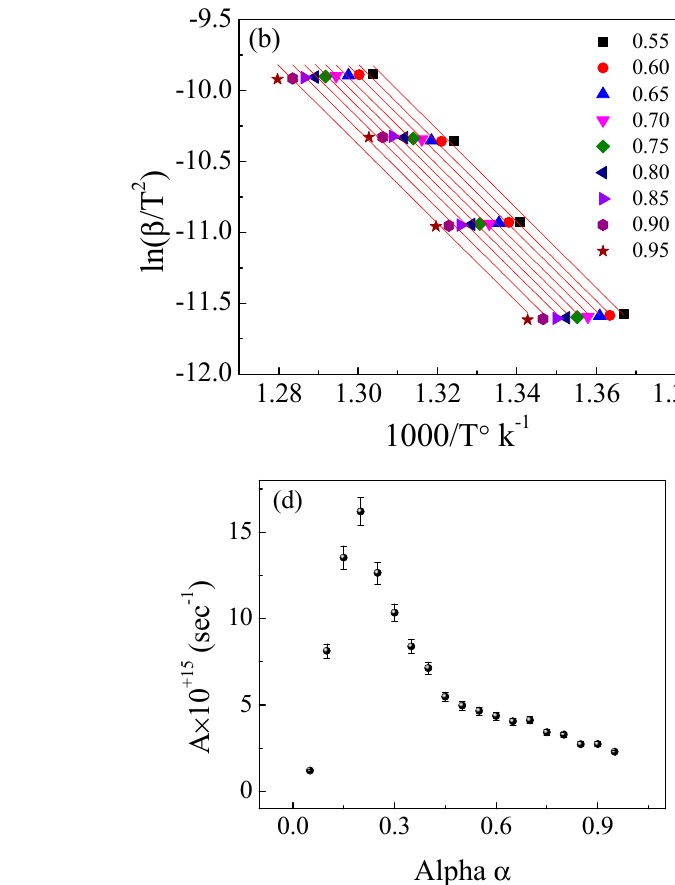
Figure 8. The Kissinger–Akahira–Sunose method for the EPDM host composite: ( a , b ) ln( β /T 2 ) versus temperature; ( c , d ) the dependence of E a and A, respectively, on conversion α .